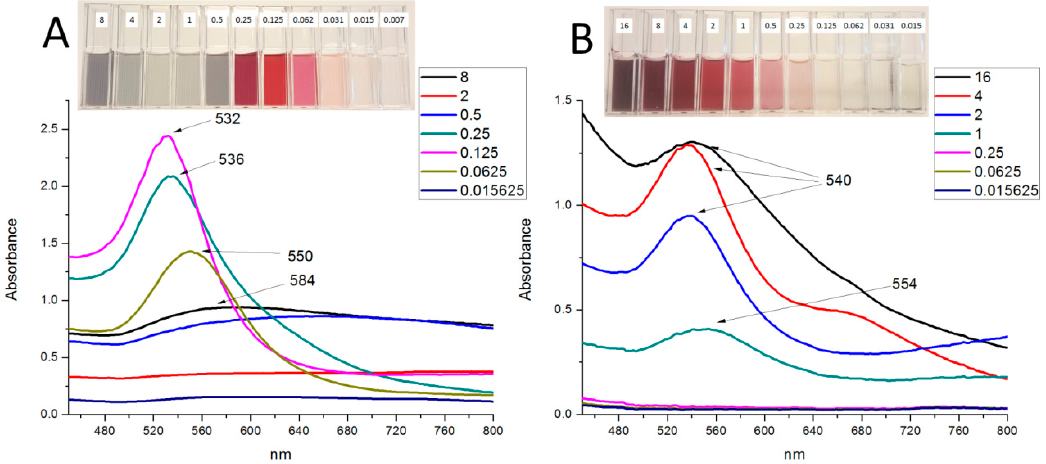
Figure 9. UV-Vis spectra for the AuNPs produced from ( A ) EGCG and ( B ) P. latifolius using different concentrations (mg/mL) at 25 °C. The insets show photos of the reaction mixture of different concentrations (mg/mL) of EGCG and P. latifolius after 1 h of reaction with gold salt.